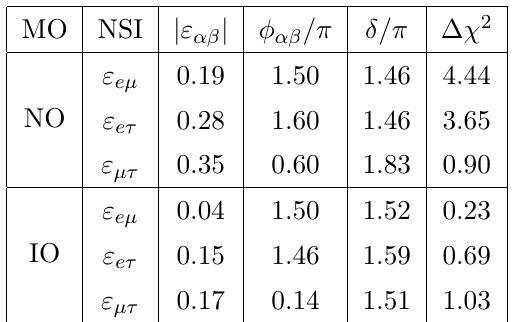
for a fixed MO considering − χ 2 SM NSI = 2 . 3 − χ 2 NO IO